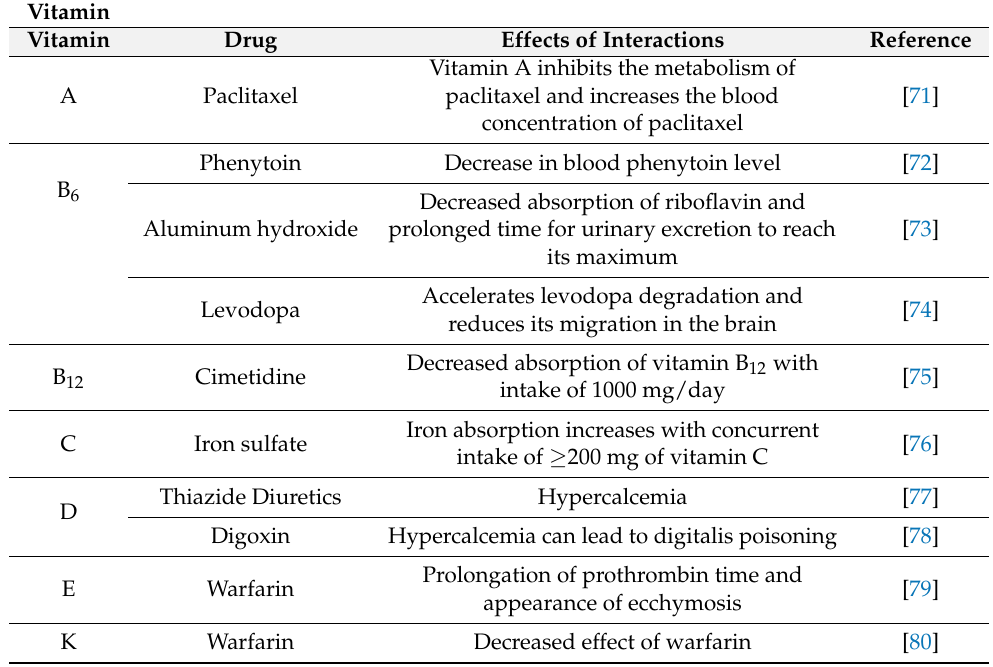
Table 2. Nutrient–drug and diet–drug